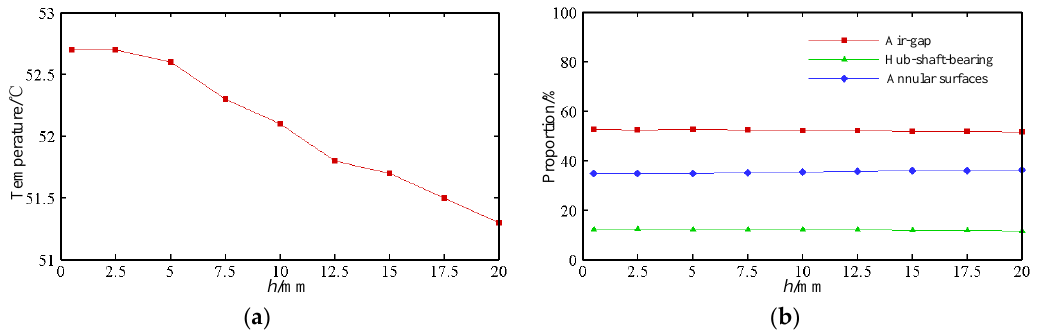
Figure 10. Influence of h on the cooling performance: ( a ) relationship diagram of h and average winding temperature; ( b ) relationship diagram of h and proportion of HTR for each cooling path.